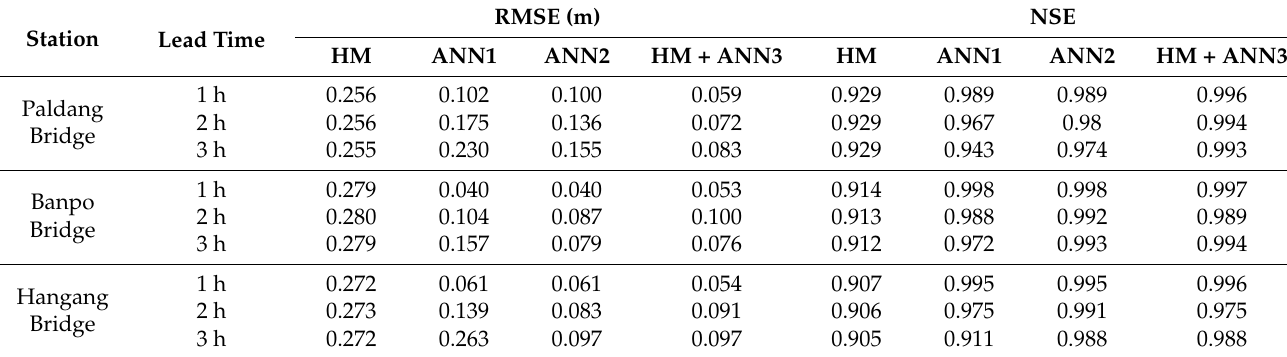
Table 6. Statistical comparison of model performances for the training